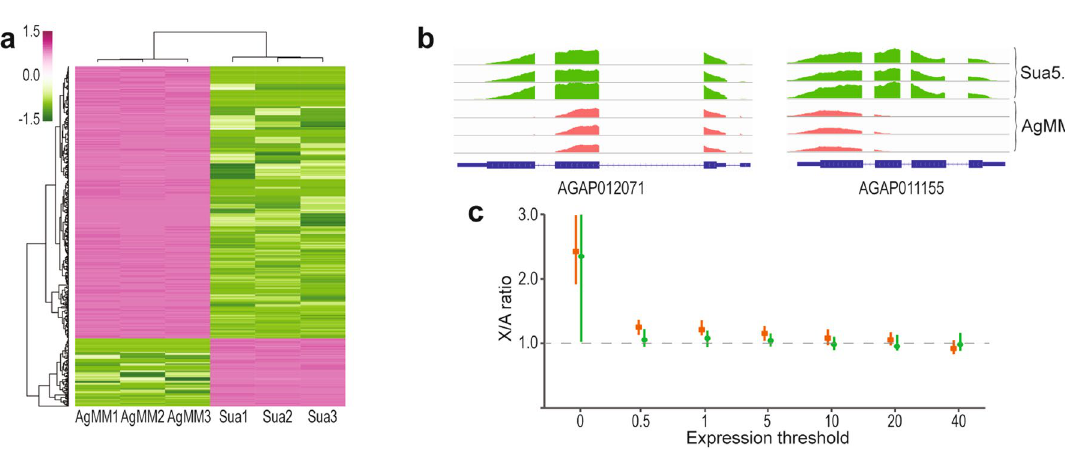
Figure 3. Analysis of expression in the AgMM and Sua5.1 cell lines. ( a ) A heat map of the top 500 genes most variable between the AgMM and Sua5.1 cells. Dark pink indicates the most positive z-score, while dark green indicates the most negative z-score. ( b ) Examples of genes with alternative transcription between the cell lines. ( c ) Analysis of dosage compensation in the AgMM cells. Chromosome-wide ratios of median expression from the X chromosome and the autosomes in the AgMM (red) and, for comparison, Sua5.1 (green) cells as a function of minimum expression (TPM) levels. For each threshold, dots represent the median and vertical bars indicate the 95% confidence intervals from